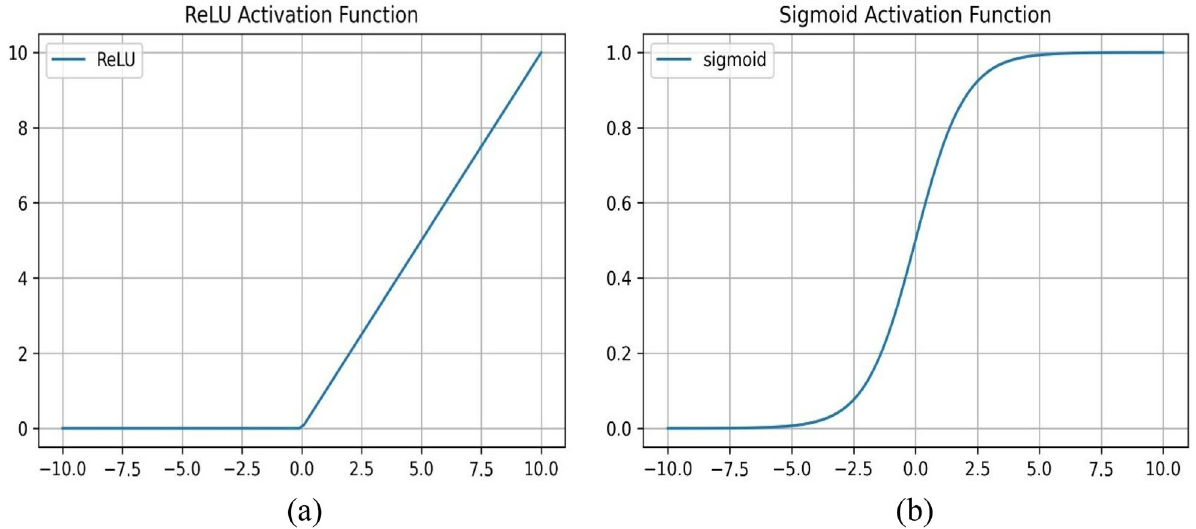
Figure 3. Schematic representation of ( a ) ReLU and ( b ) σ